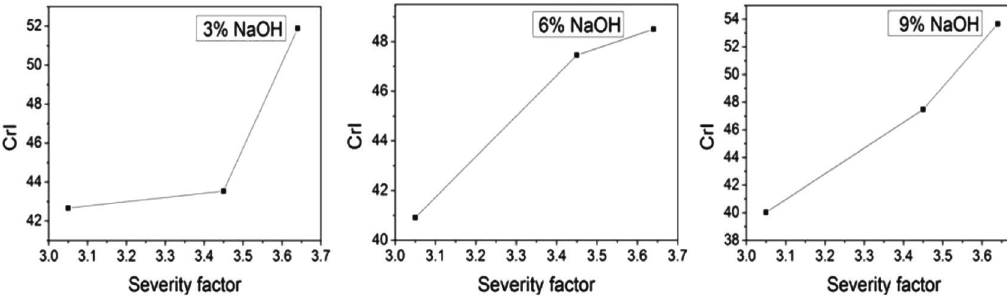
Fig. 4 – Relationship of cellulose crI and steam explosion severity at various sodium hydroxide